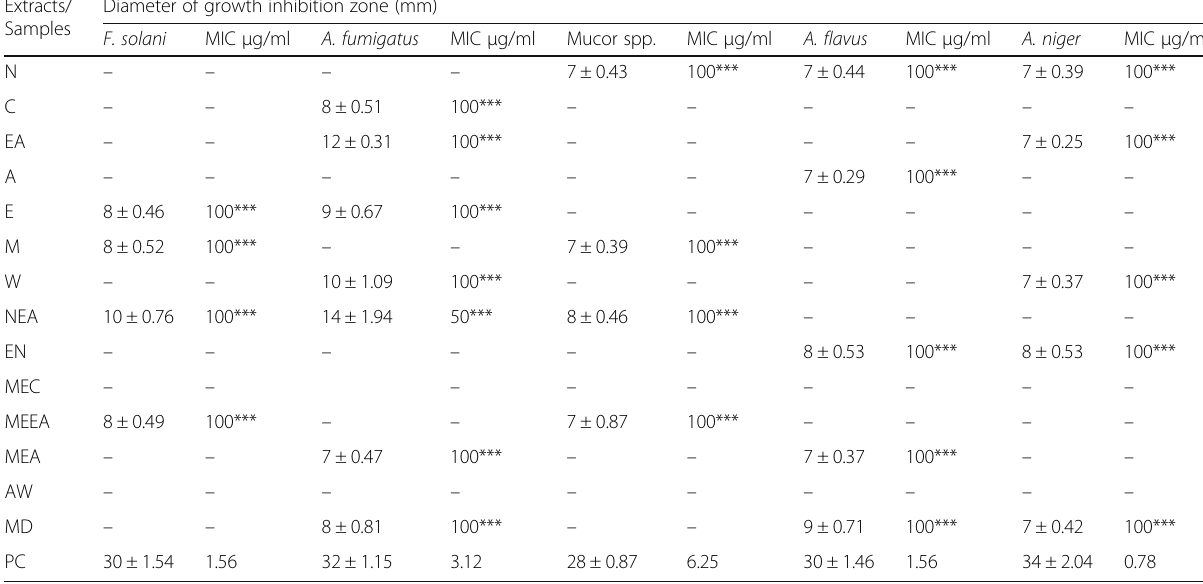
Table 4 Antifungal activity of A. lasiantha against various fungal strains Extracts/ Diameter of growth inhibition zone Samples